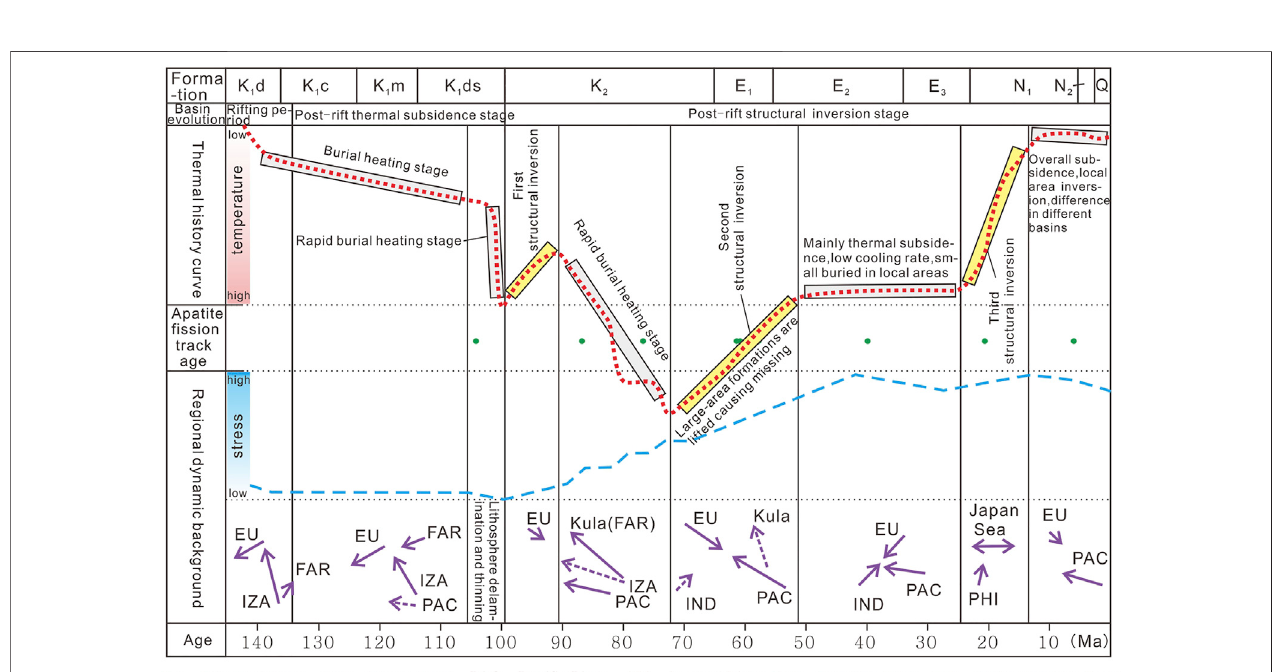
FIGURE 9 | Corresponding relationship between tectonic-thermal evolution and plates movement in the Dasanjiang uni fi ed basin. The red dashed line represents thecomprehensivecurveofthethermalhistory ofthebasin;theblue dashed linerepresents themagnitudeofintraplate stress;thegreendotsrepresentthe fi ssiontrack age; thearrow represents theabsolutemovementdirection ofthe plates, theline lengthrepresentsthe moving speed, and the dashed linerepresentsthe emergence or extinctionoftheplates.Plateactivities data(modi fi edafterEngebretson etal.,1985;NorthurpandRoyden,1995;Maruyama etal.,1997;Molnarand Stock,2009; Copley et al., 2010).